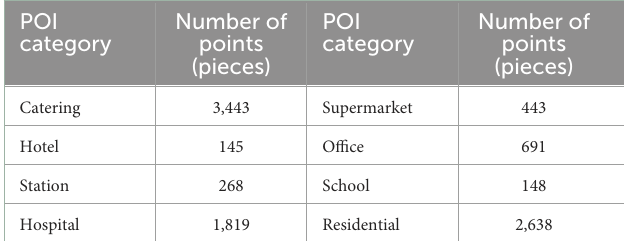
TABLE 1 Classification of map POI